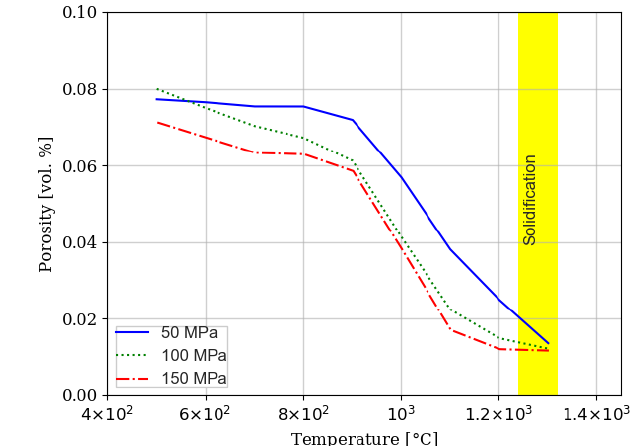
Figure 40: Porosity in SLM IN718 components after different HIP’ing pressures and temperatures [55].